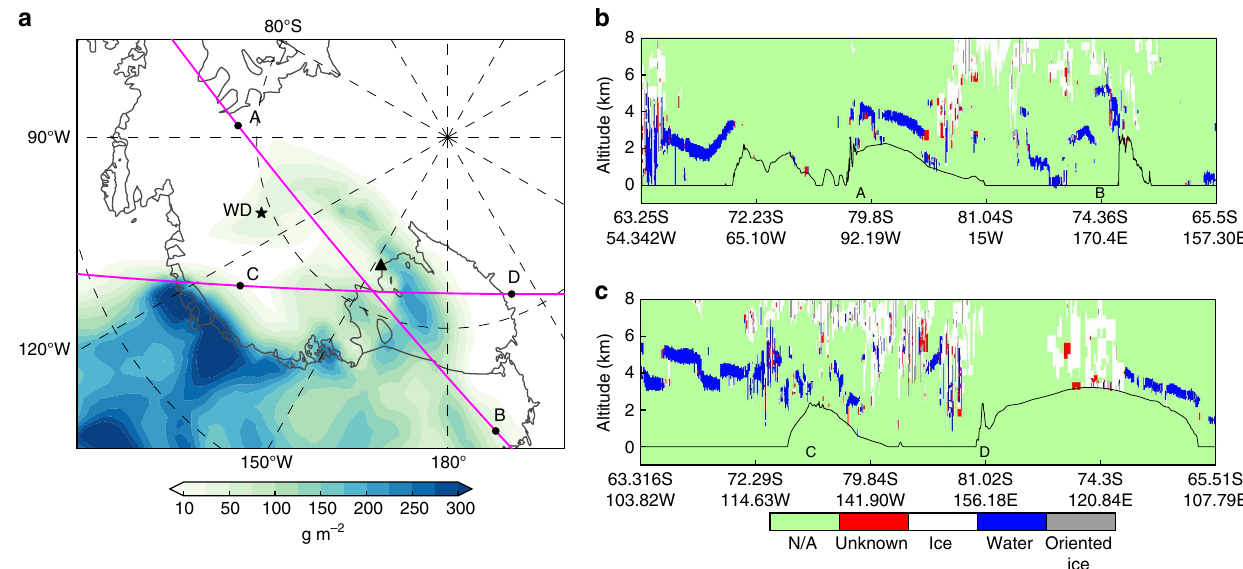
Figure 2 | Cloud liquid water simulated by ERA-Interim and detected by CALIPSO lidar on 12 January 2016. ( a ) Map of cloud liquid water path (CLWP) simulated by ERA-Interim for 06:00 UTC on 12 January 2016. The black star denotes the location of WAIS Divide. The two pink lines represent the CALIPSO satellite trajectories corresponding to the vertical profiles shown in b , c . The points labelled A, B, C and D along these trajectories are identical to those shown at the bottom of the vertical profiles. The black triangle denotes where rain was witnessed by a field party on 12 January (Dr Huw Horgan, Victoria University of Wellington, personal communication). ( b , c ) Vertical profiles of ice/water phase retrievals from CALIPSO Lidar Level 2 data products over West Antarctica for two time windows on 12 January 2016 (4:15–4:29 UTC in b and 7:33–7:46 UTC in c ). The thin black line represents the surface topography.